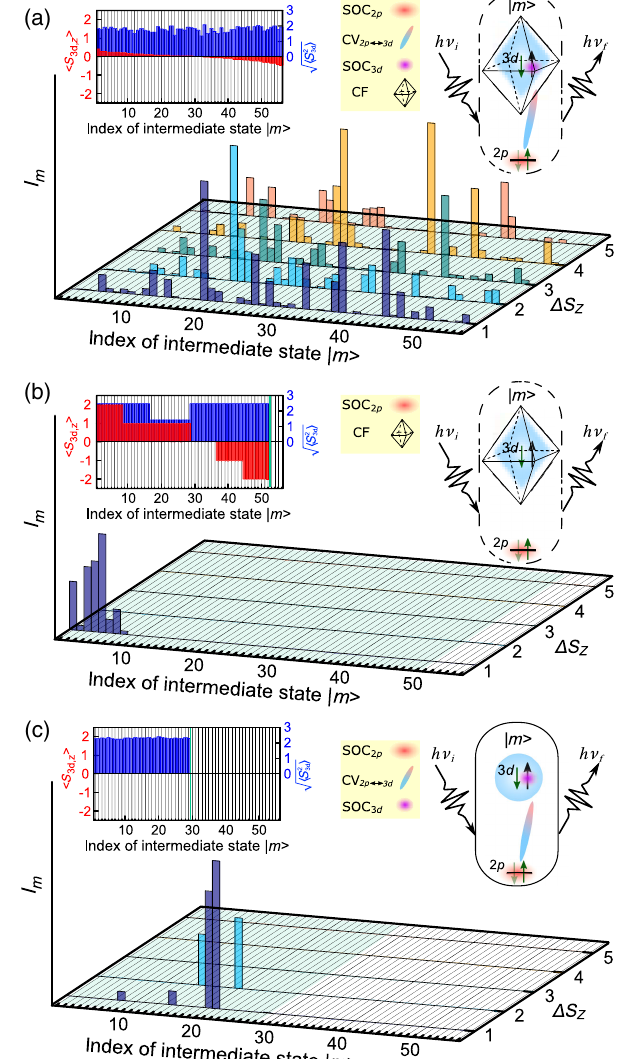
¼ jh f j T j m ih m j T j g ij 2 FIG. 4. Calculated RIXS amplitude I m e i of the magnetic excitations [the numerator part of the first term in the Kramers-Heisenberg formula; see Eq. (S1) of the Supplemental Material [40] ] from the ground state j g i to the final state j f i via different intermediate states j m i with energies ∈ ½ E (cid:2) 0 . 3 eV (cid:4) ( E E denotes the Fe- e absorption en- m L 3 L 3 g ergy), using the local atomic model. (a) Amplitude I when m SOC 3 , SOC 2 , CV 2 , and CF interactions are switched on. d p p ↔ 3 d (b) Amplitude I when SOC 3 and CV 2 are off (i.e., m d p ↔ 3 d SOC 2 and CF are on). (c) Amplitude I when CF is off (i.e., p m SOC 3 , SOC 2 , CV 2 are on). Within the selected L 3 -edge d p p ↔ 3 d energy window, we consider 56, 51, and 29 j m i states with different eigenenergies E (indicated by the green shaded area), m respectively, for (a), (b), and (c), accounting for 95% of the total calculated RIXS intensity (integrated over the energy loss) at a given photon energy ( E ). The insets on the left of each plot L 3 ˆ i S 3 summarize the h d;z